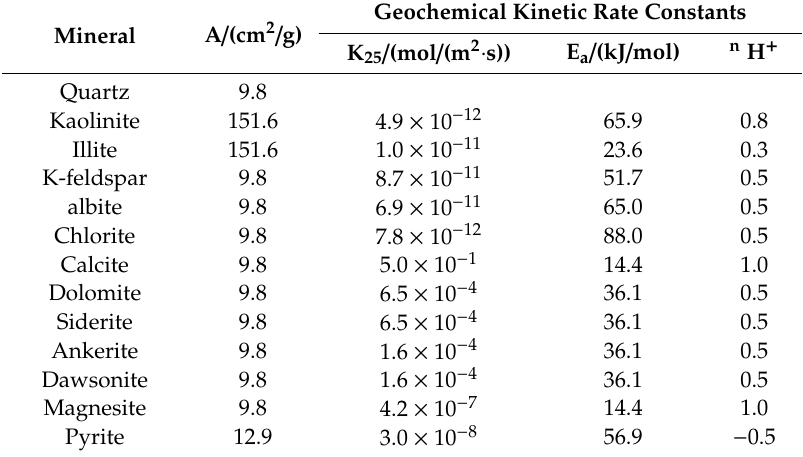
Table 2. List of minerals considered and parameters for calculating the kinetic rate constants. Mineral